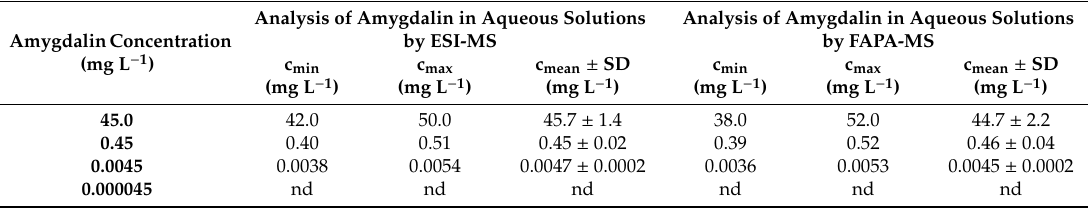
Table 2. Results of amygdalin determination in aqueous solutions by ESI-MS and FAPA-MS methods.